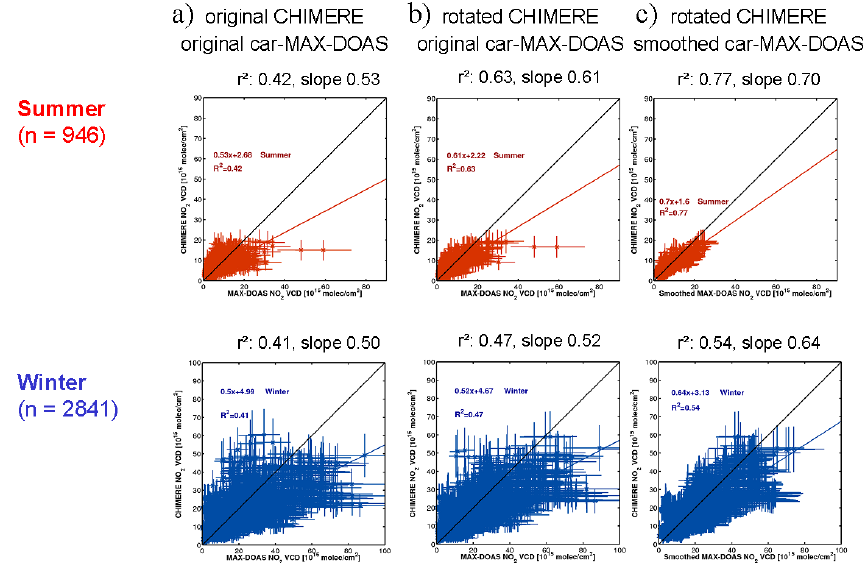
Figure 13. Correlation analyses between CHIMERE and car-MAX-DOAS observations (along large circles) for (a) the original data sets, (b) rotated CHIMERE data, and (c) rotated CHIMERE data and smoothed car-MAX-DOAS